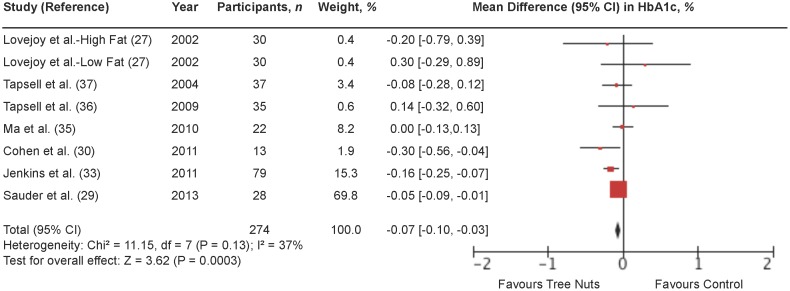
Forest plot of randomized controlled trials investigating the effect of diets supplemented with tree nuts on HbA1c in individuals with type 2 diabetes.Pooled effect estimate (diamond) for HbA1c (%). Data are expressed as weighted mean differences (MD) with 95% CIs, using the generic inverse-variance fixed effects model. Paired analyses were applied to all crossover trials. Inter-study heterogeneity was tested by the Cochran Q-statistic and quantified by I2 at a significance level of P<0.10. n = number of participants in each treatment group.